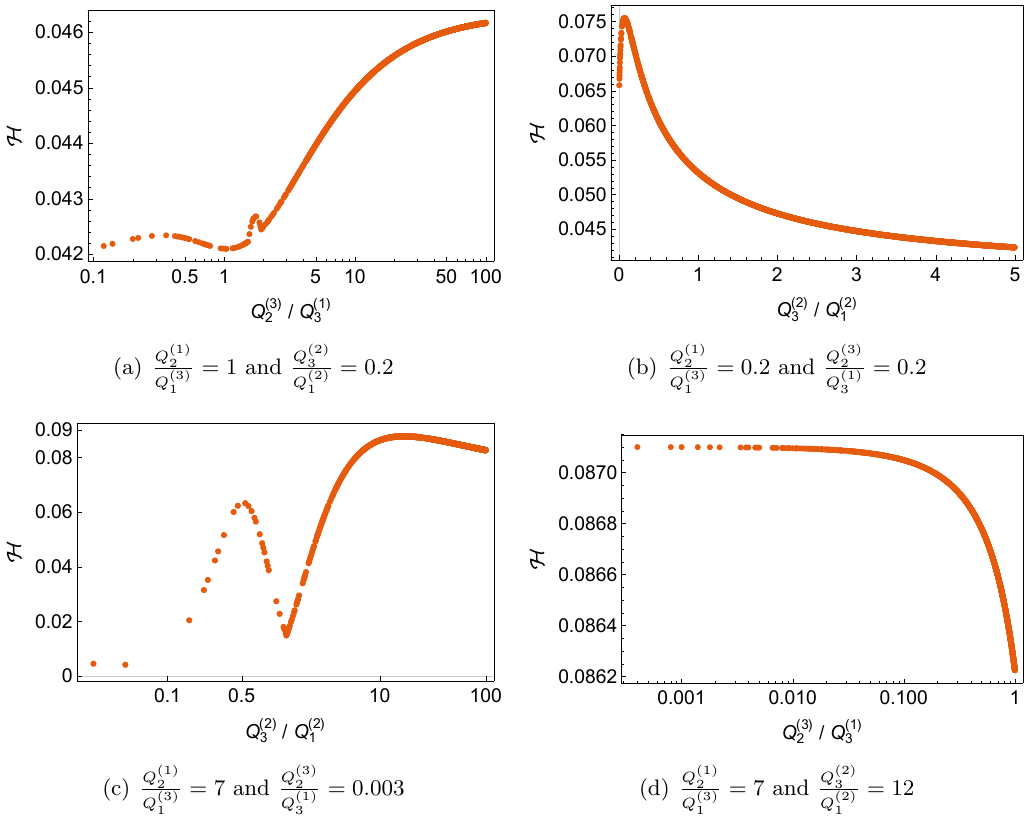
Figure 3 . The entropy parameter H as a function of one of the charge ratios with q , k 1 , (cid:0) k 2 and k 3 equal to 1.